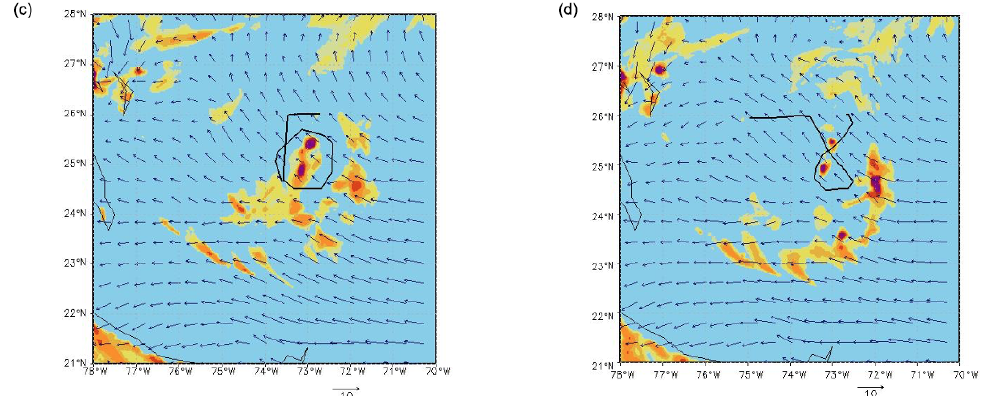
Figure 4. Same as Fig. 3, but after the assimilation of DAWN wind vector profiles.